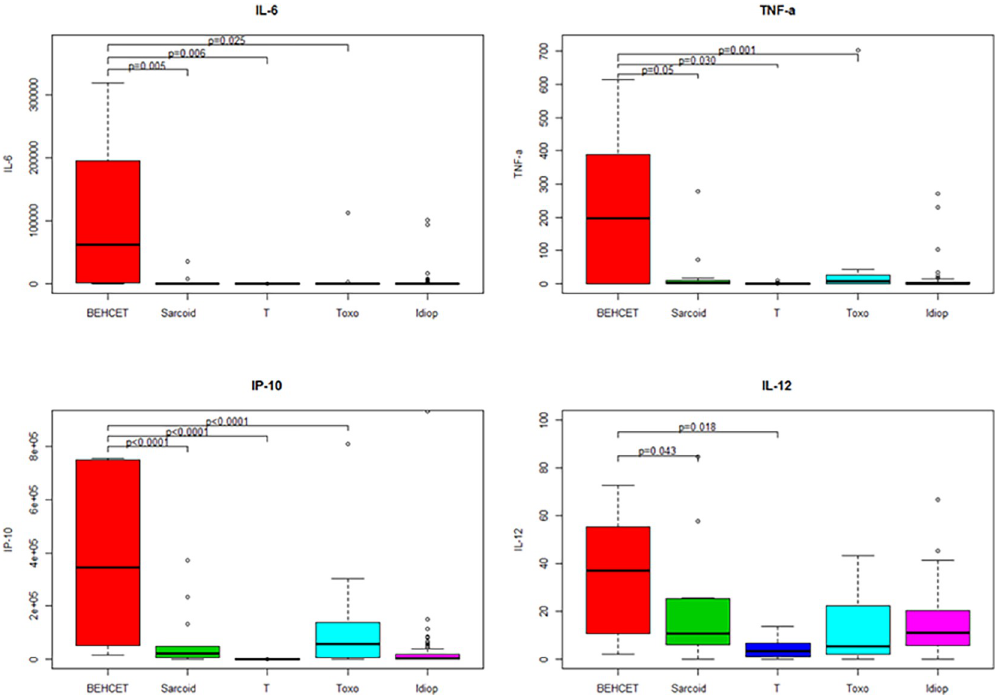
Fig 9. Boxplots of 4 immune mediators significantly elevated in the aqueous humor of patients with idiopathic uveitis (Idiop): IL-6, TNF- α , IL-12 and IP-10, as compared to immune mediators in the aqueous humor of patients with uveitis related to Behc¸et disease, sarcoidosis, TU (Toxo) and noninflammatory controls (T). Significant P values are noted in the upper part of each graph. A P value < 0.05 was considered significant.